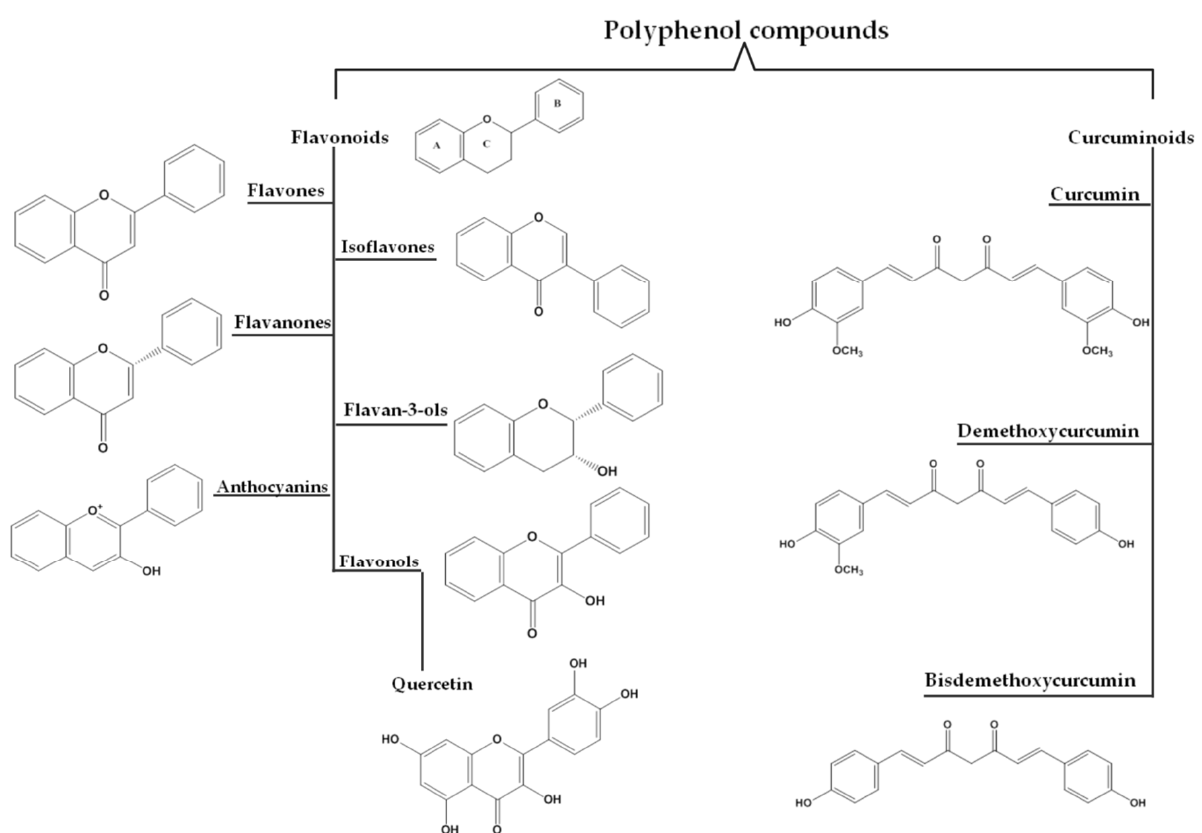
Figure 2. Biosynthesis pathways of flavonoids and curcuminoids.